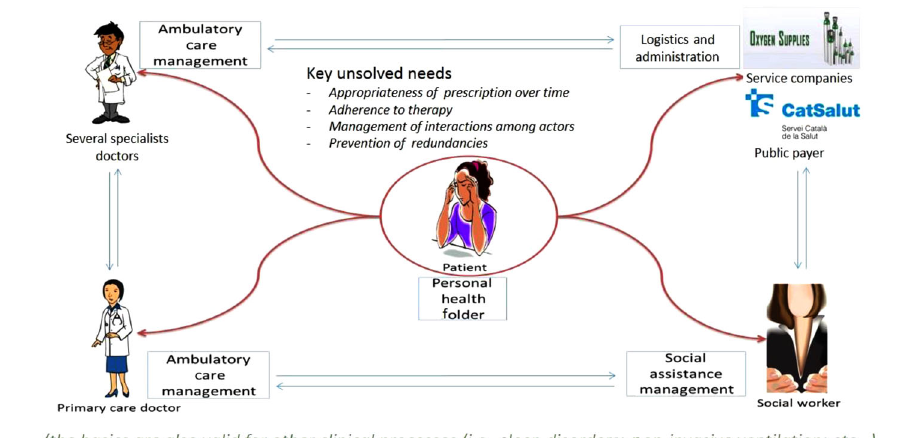
Fig. 4 Integrated Care Management of patients under LTOT